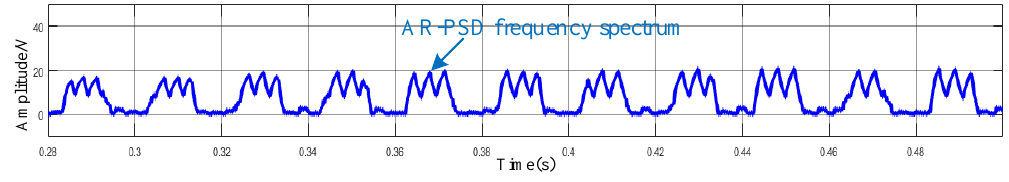
Figure 24. Frequency spectrum and demodulated data as the transmission resistance is 4 Ohm.